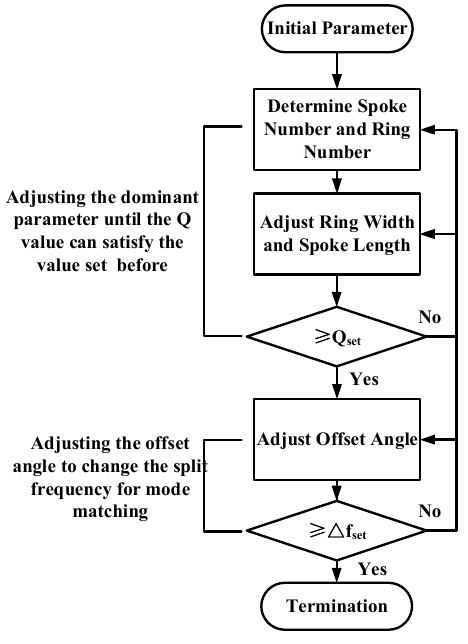
Figure 11. Parameters selection process for DRG.